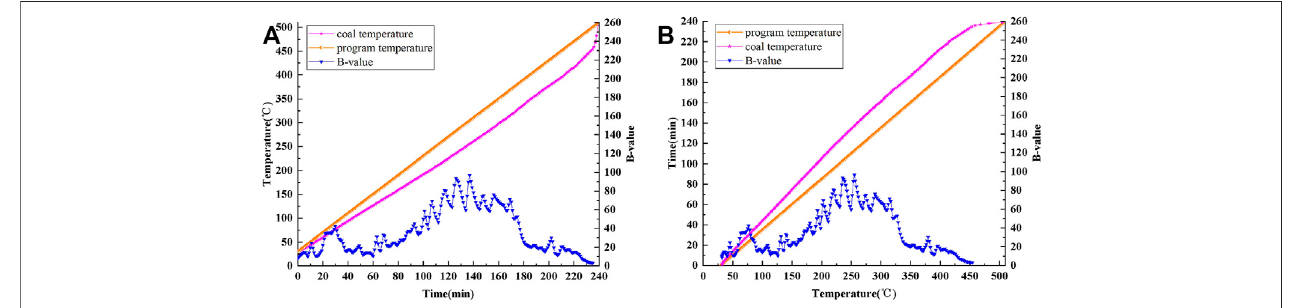
FIGURE 5 | Curves of program temperature, coal temperature and B-value: (A) time-varying, (B) temperature-varying.